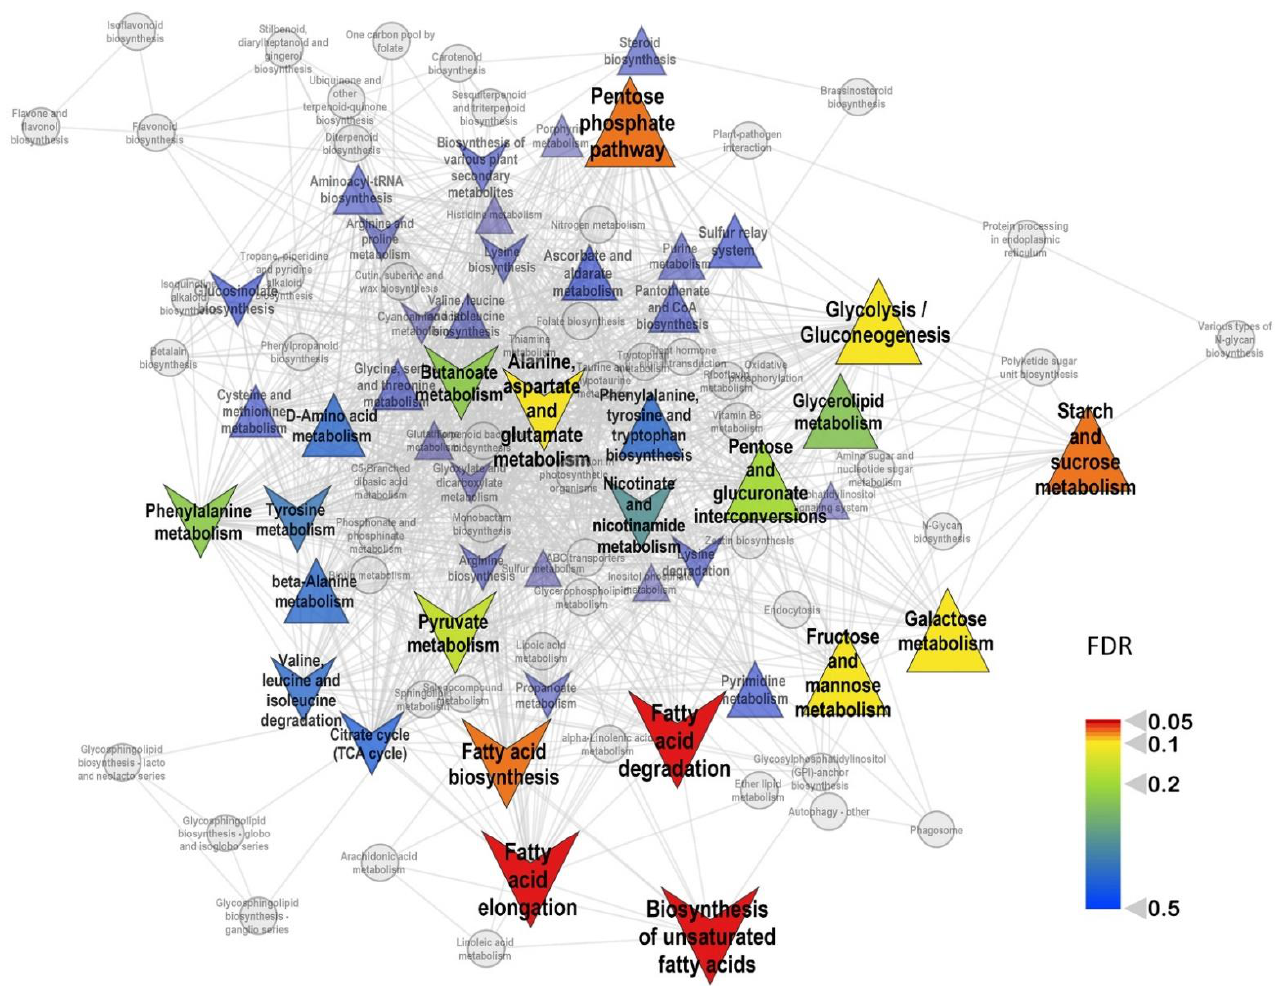
Figure 5. Metabolite sets enrichment analysis based on loadings from OPLS-DA classification of mycorrhized (AM+) and non-mycorrhized (AM − ) roots at 24 DAS. Nodes are the paths extracted from KEGG. If paths share metabolites, they are connected by an edge. Color — significance of influence on this pathway; size — strength of influence (|NES|); upward triangles — upregulation at AM+; downward direction — downregulation.